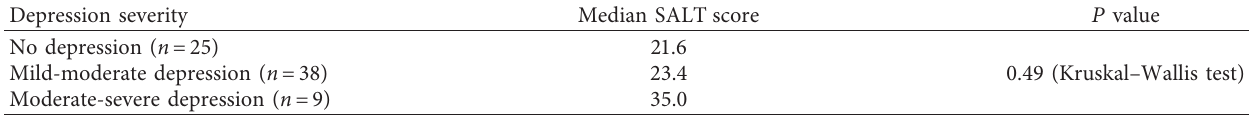
Table 1: Relation between depression and SALT score.